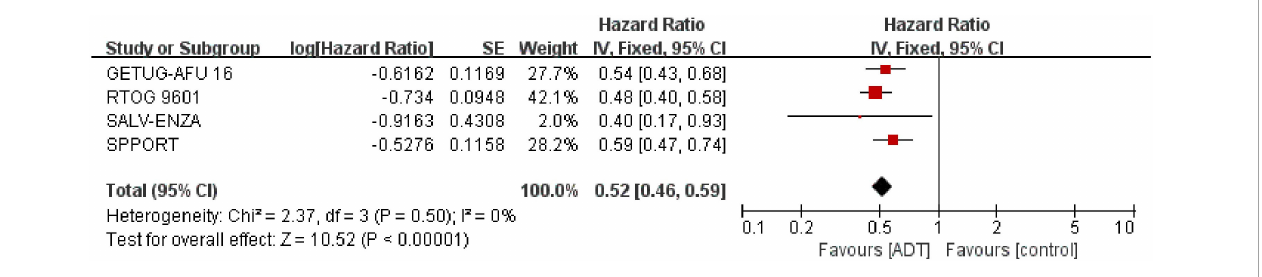
FIGURE 2 Assessment of biochemical Progression Free Survival. The diamond indicates best estimate of the true (pooled) outcome (with width indicating 95% CI); HR, hazard ratio; experimental stands for salvage radiotherapy combined with endocrine therapy; control stands for salvage radiotherapy alone. Since there is no heterogeneity, a fi xed-effects model is used.